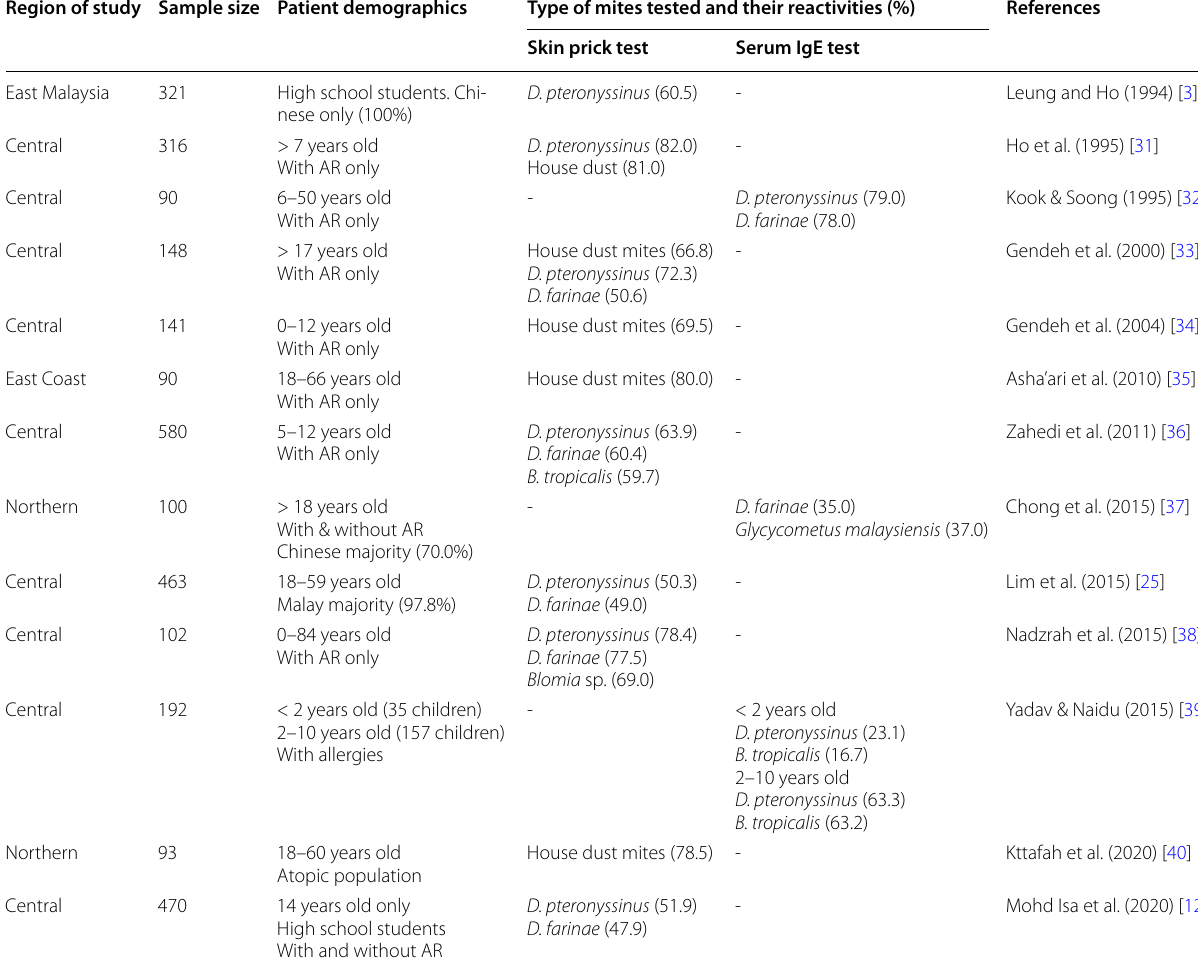
Table 2 Summary of skin prick tests and serum IgE tests among mite-induced allergies in different regions of Malaysia Region of study Sample size Patient